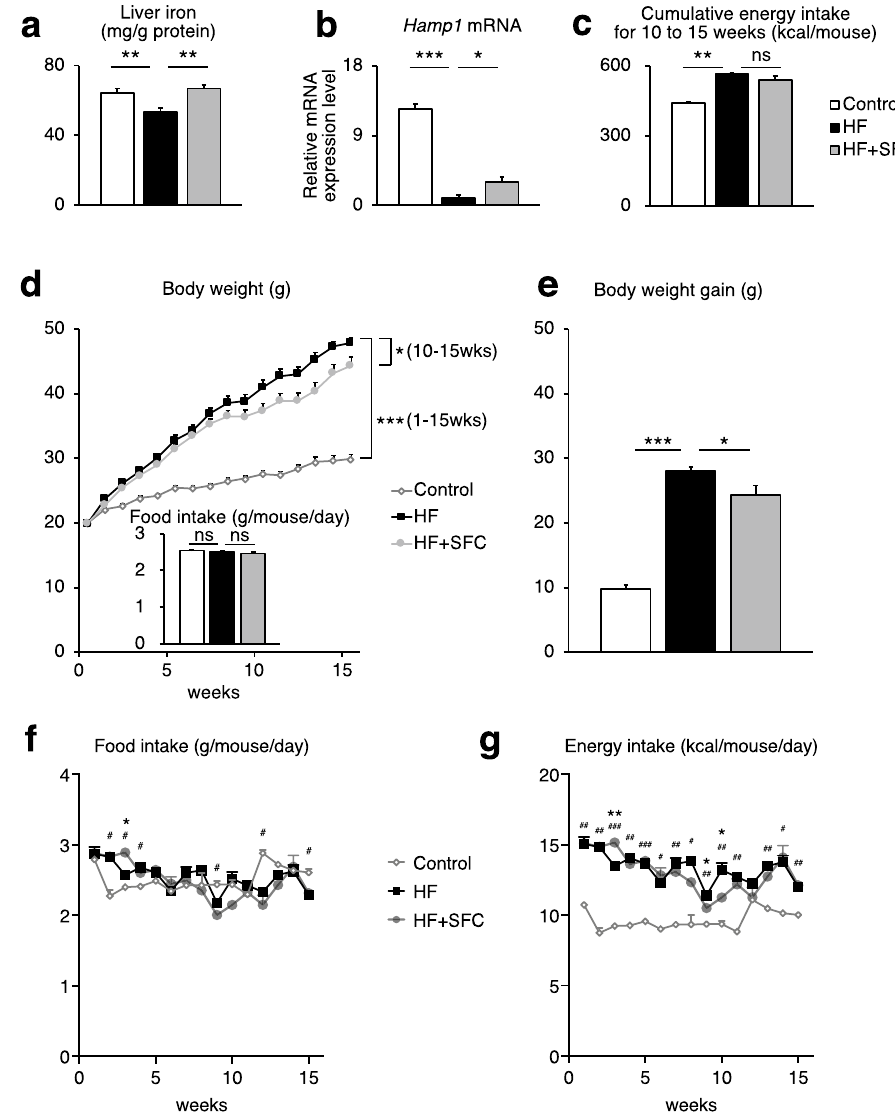
Figure 1. Iron supplementation reduces diet-induced weight gain. ( a – g ) Male C57BL/6J mice of 6 weeks of age were fed with an open source control diet (Control; 10% kcal fat), a high-fat diet (HF; 60% kcal fat), or a high- fat diet supplemented with sodium ferrous citrate (HF + SFC) for 15 weeks. ( a ) Liver iron content. The values were corrected using tissue protein levels ( n = 5–6). ( b ) Analysis of Hamp1 mRNA expression ( n = 4–6). ( c ) Cumulative energy intake for 10–15 weeks per mouse per cage. ( d ) Body weight and food intake in the different groups ( n = 11–12). Food intake was measured for 15 weeks. ( e ) Body weight gain from 0 to 15 weeks after administering ( n = 11–12). ( f , g ) Longitudinal, ( f ) food, or ( g ) energy intake. Data are shown as mean ± SEM values. Statistical analysis was performed using one-way ANOVA followed by Holm–Sidak’s post hoc test. ( a – e ) * p < 0.05; ** p < 0.01; *** p < 0.001; ns, not significant. (Significant differences vs. HF). ( f , g ) * p < 0.05. (Significant differences in HF vs. HF + SFC). # p < 0.05; ## p < 0.01; ### p < 0.001. (Significant differences in HF vs.